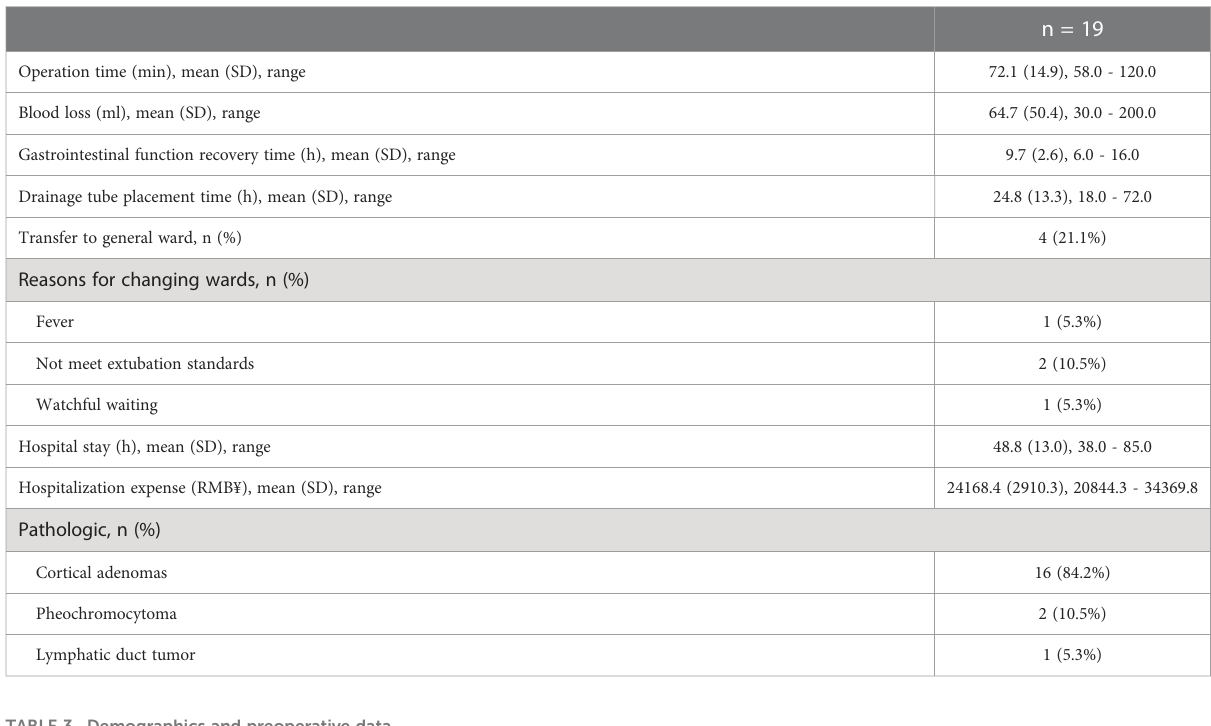
TABLE 3 Demographics and preoperative data.